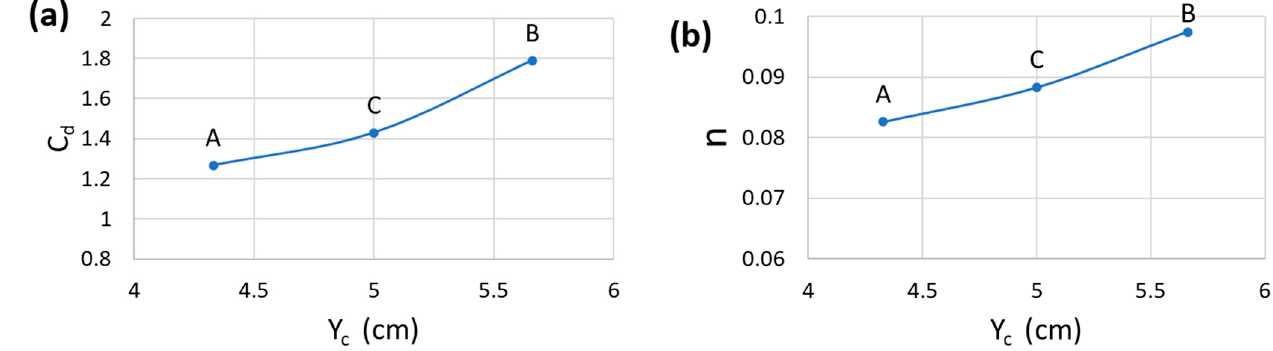
Figure 6. The relation between y c and the drag coefficient (a), y c and Manning’s coefficient (b).